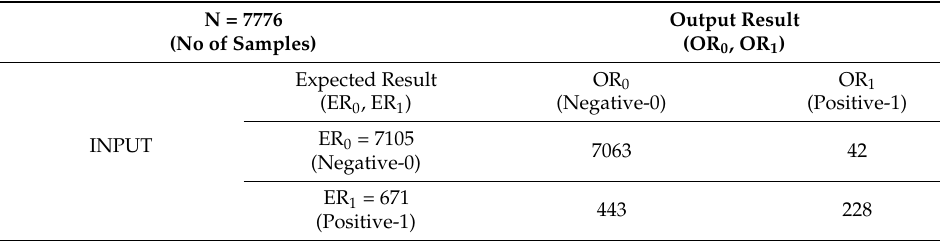
Table 12. Fused ML testing results.